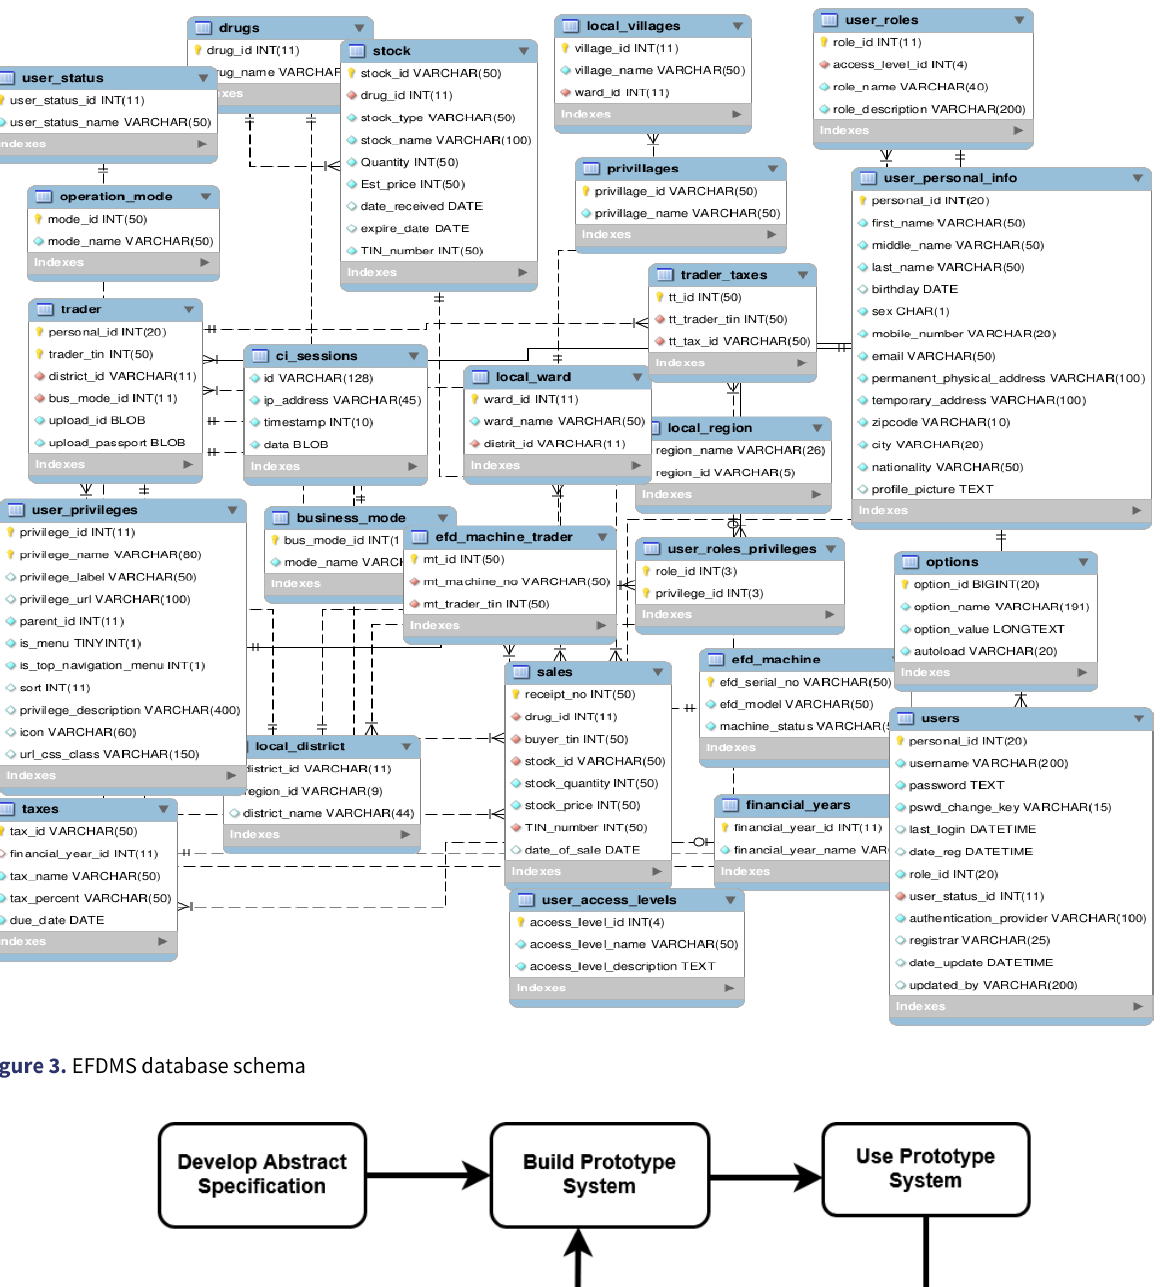
Figure 4. Evolutionary prototype